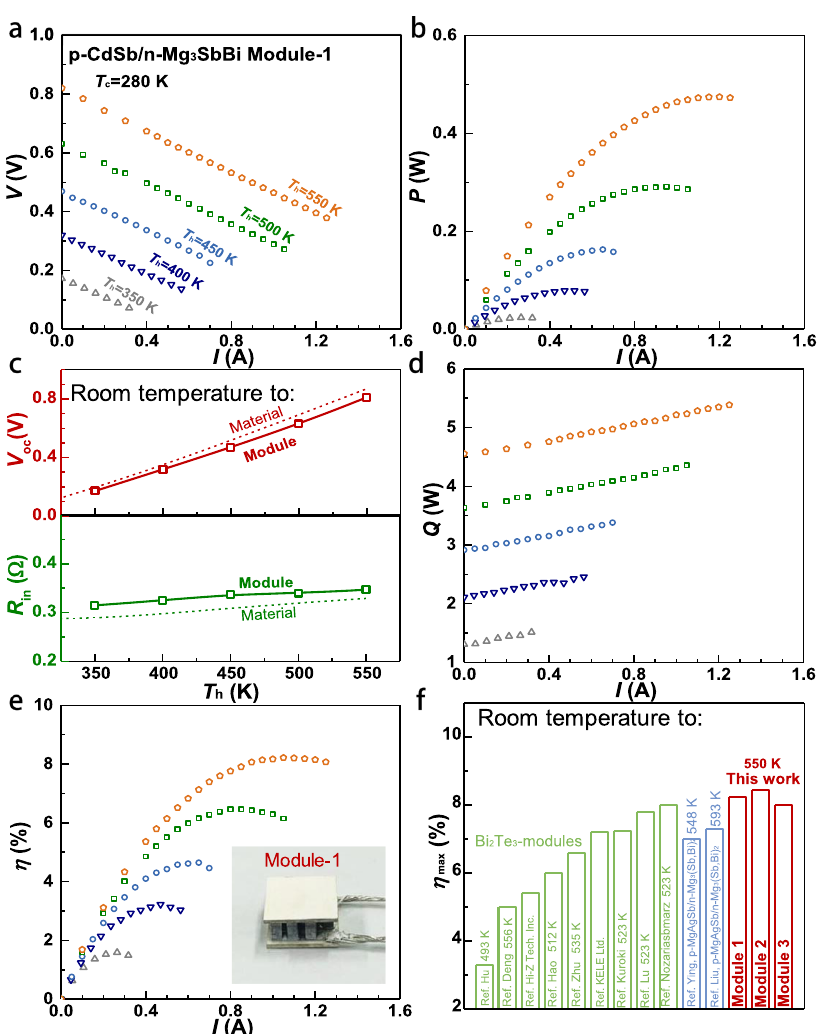
Fig. 5 Module properties. Current ( I ) dependent output voltage ( V ) ( a ) and output power ( P ) ( b ), open-circuit voltage ( V oc ) and internal resistance ( R in ) ( c ), heat- fl ow ( Q ) from cold-side ( d ), conversion ef fi ciency ( η ) ( e ) and its maximum η max ( f ) under hot-side temperature of 550K for CdSb/Mg 3